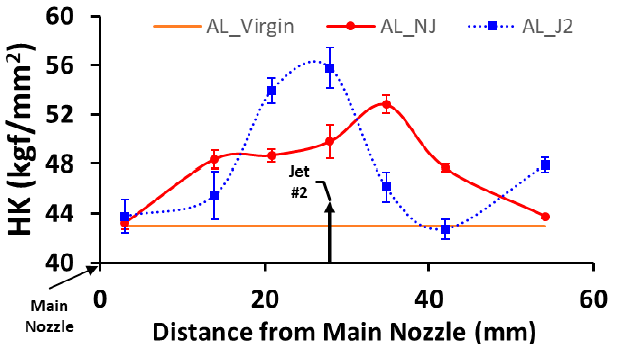
Figure 11. Hardness distribution on the specimen with no jet and with a secondary jet.